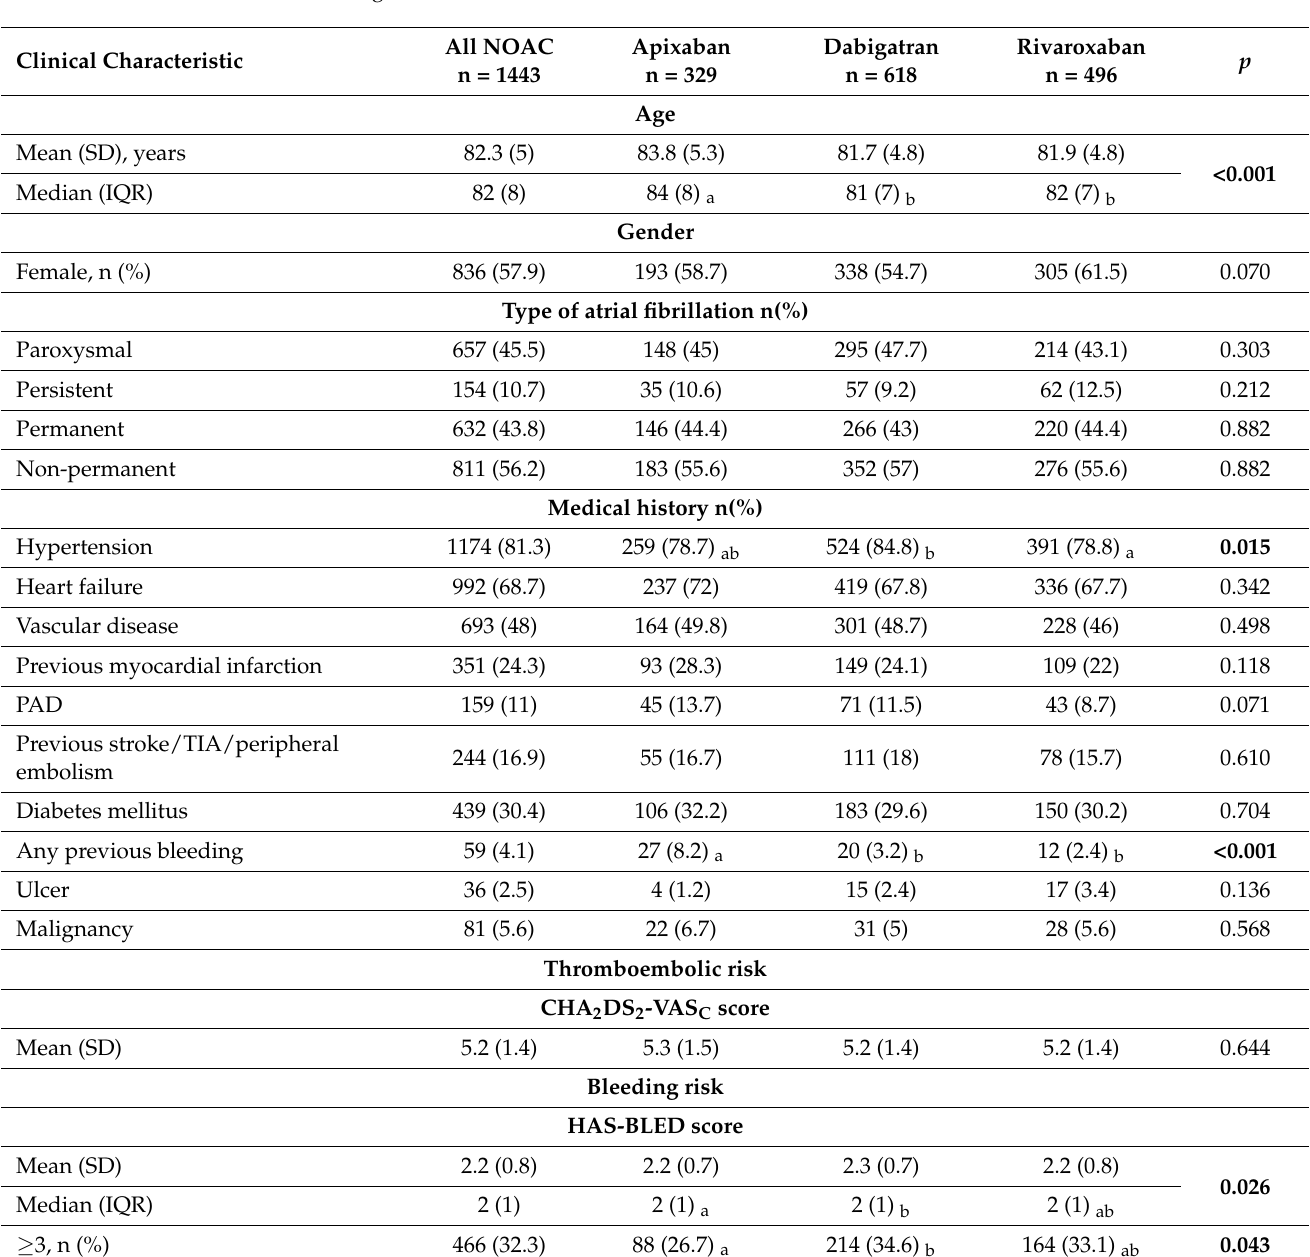
Table 1. Clinical characteristics of patients treated with apixaban, dabigatran and rivaroxaban. Results of the laboratory test and echocardiographic examinations of patients treated with apixaban, dabigatran and